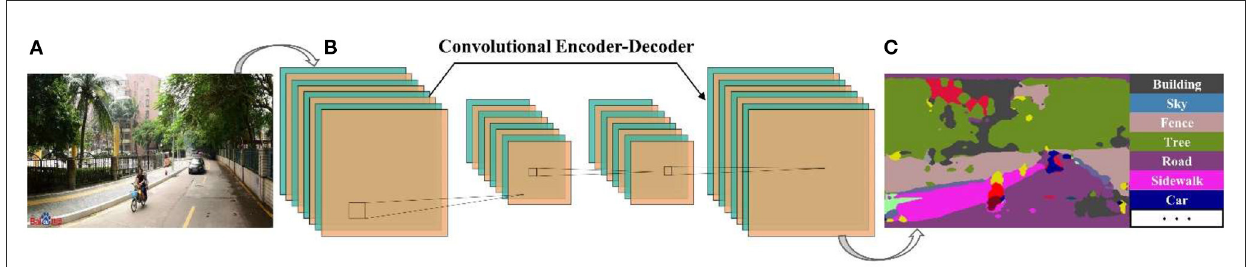
FIGURE3 Overview of semantic image segmentation using SegNet trained on Cityscapes dataset: (A) input urban natural image; (B) SegNet architecture; (C) output image with segmentation mask.